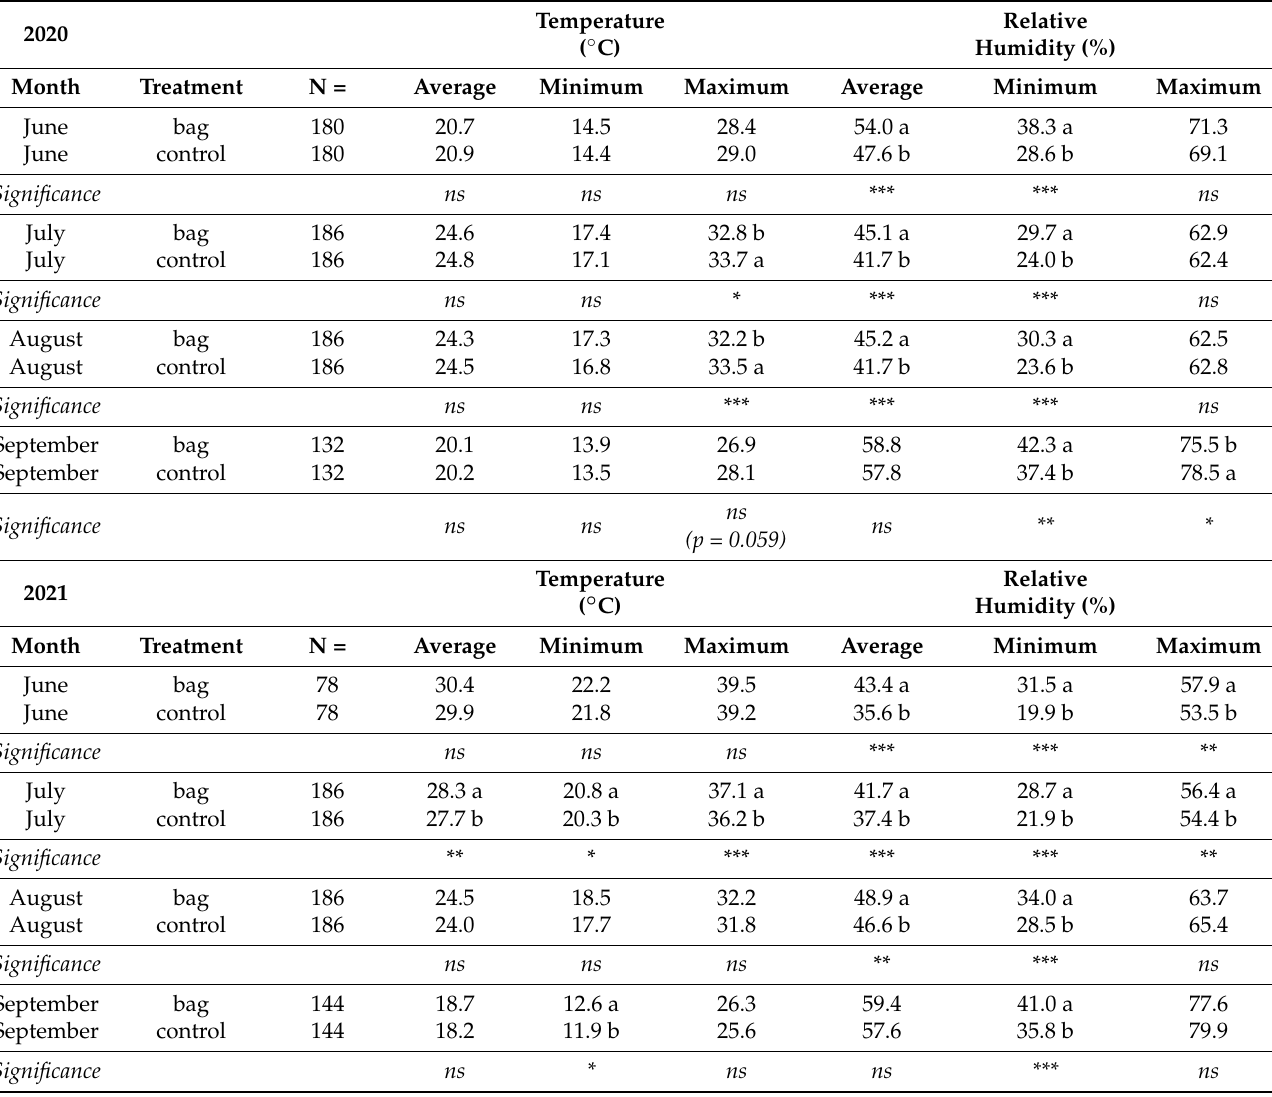
Table 1. Temperature ( ◦ C) and percent relative humidity (%RH) measurements inside fruit bags (bag) compared to the non-bagged (control) in the 2020 and 2021 seasons. Monthly averages of daily average, minimum and maximum temperatures ( ◦ C), and average, minimum and maximum RH (%), were compared. N = indicated the number of observations generating the means for each month and season. Different letters within comparisons indicate statistical differences between means ( p =